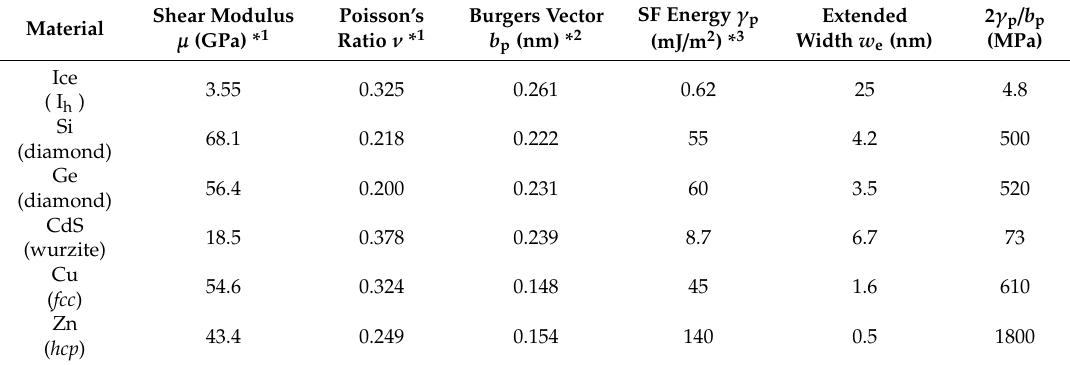
Table 3. Parameters involved with dissociation into two Shockley partials of a perfect screw dislocation in various